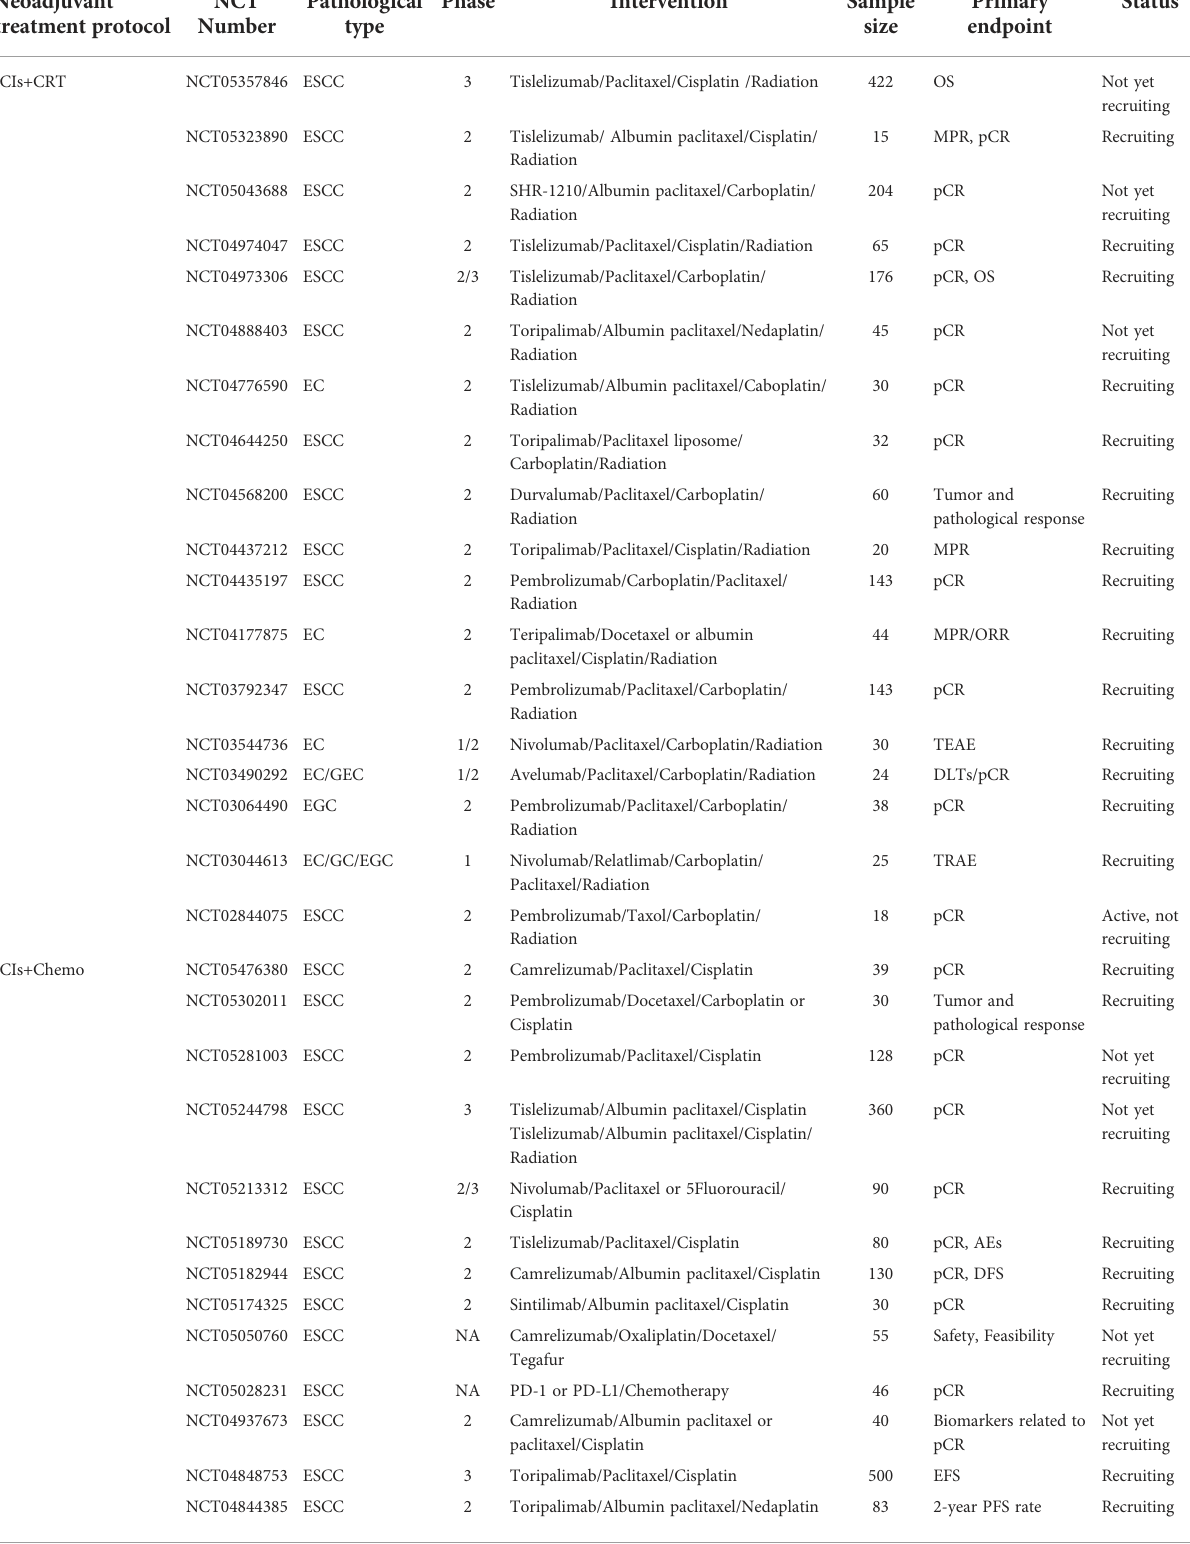
TABLE 2 Registered clinical trials in ClinicalTrials.gov investigating neoadjuvant immunotherapy for the treatment of resectable esophageal cancer. Neoadjuvant treatment